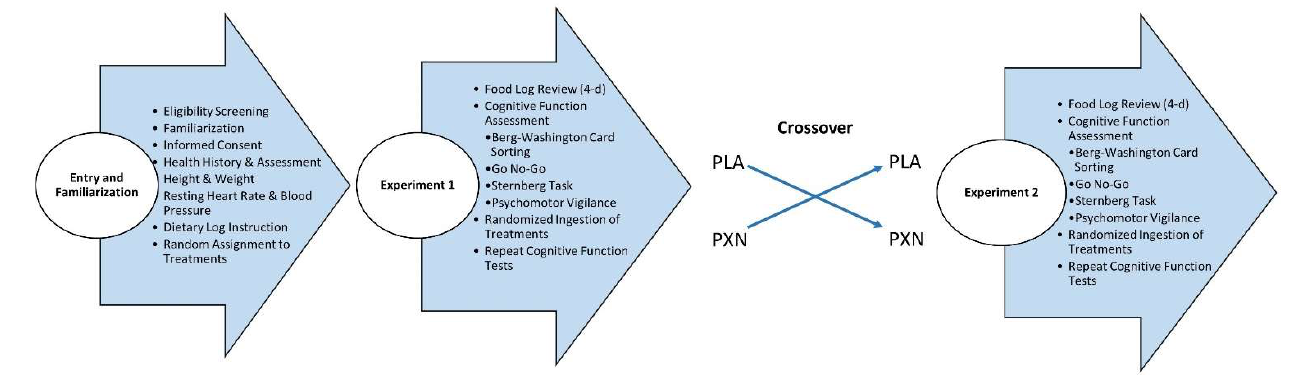
Figure 2. Overview of study protocol.